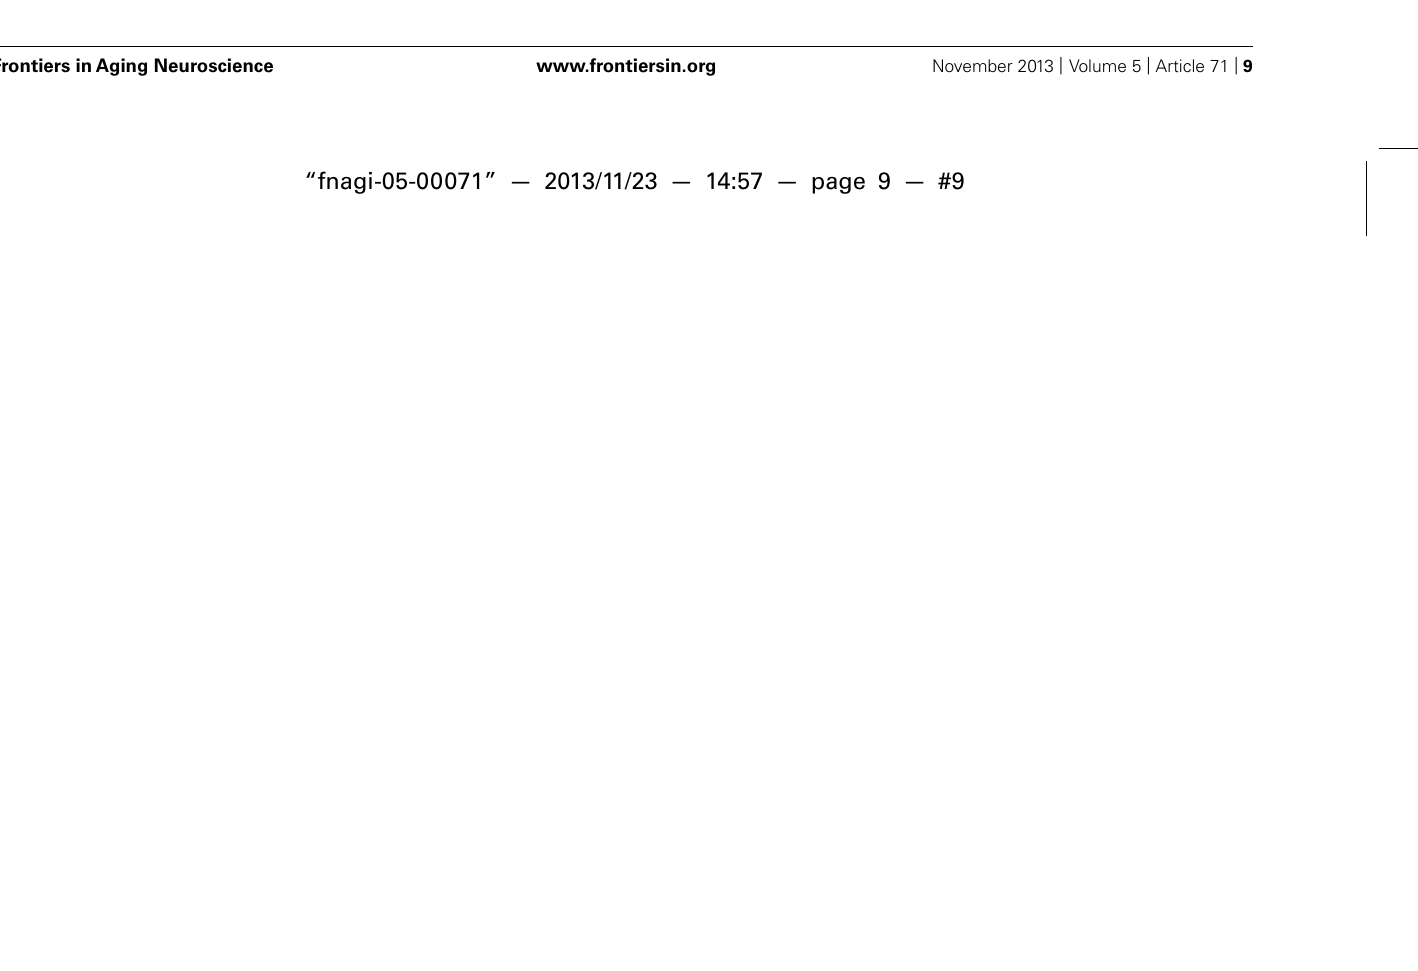
right amygdala, according to the mean diffusivity. Consistent